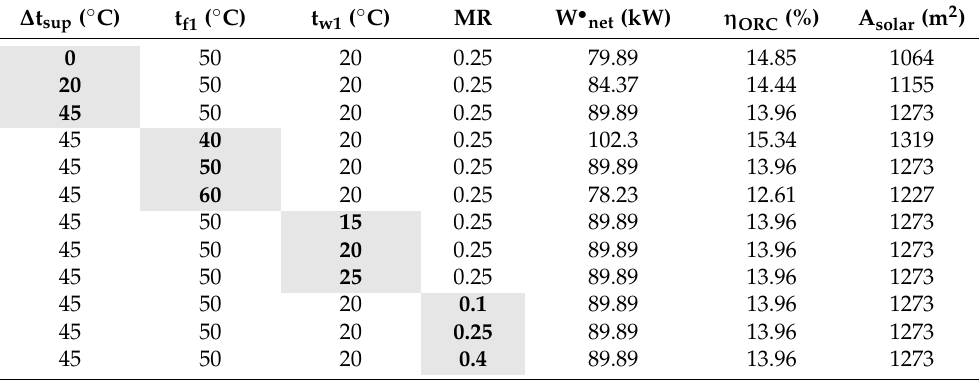
Table 4. Power, ORC thermal efficiency, and area of solar collectors for MGS-I and